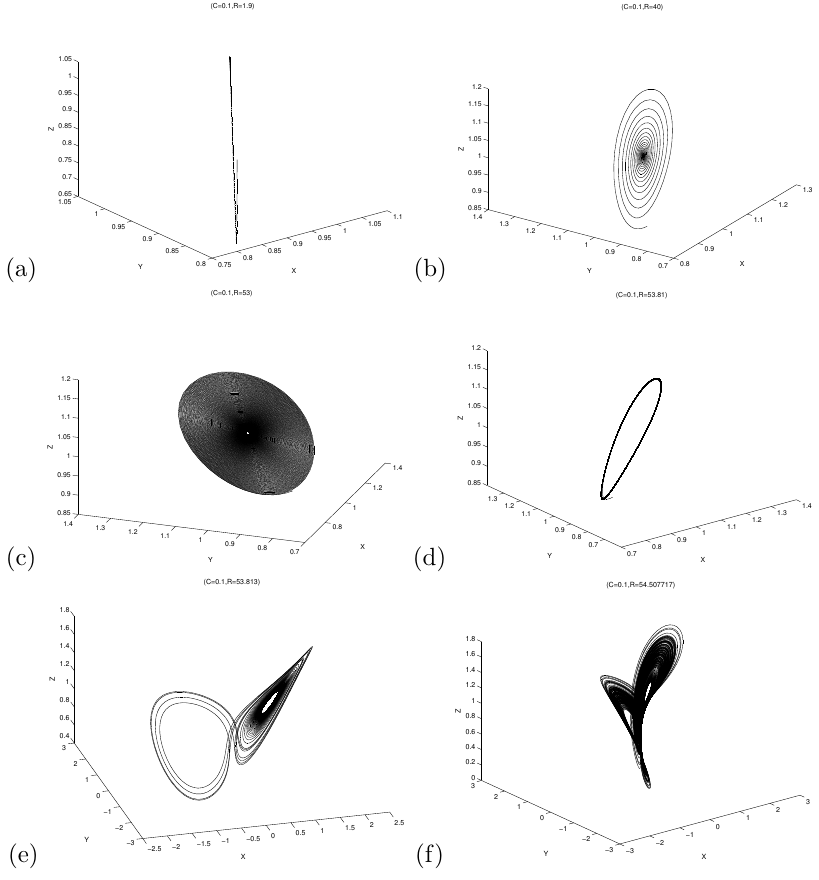
Figure 4. Computational results for the evolution of trajectories over time in the state space for increasing values of scaled Rayleigh number ( R ). The graphs represent the projection of the solution data points onto X - Y - Z plane for Pr = 10, λ = 8 / 3 and C = 0 . 1 for (a) R = 1 . 9, (b) R = 40, (c) R = 53, (d) R = 53 . 81, (e) R = 53 . 813, (f) R = 54 . 50771700.